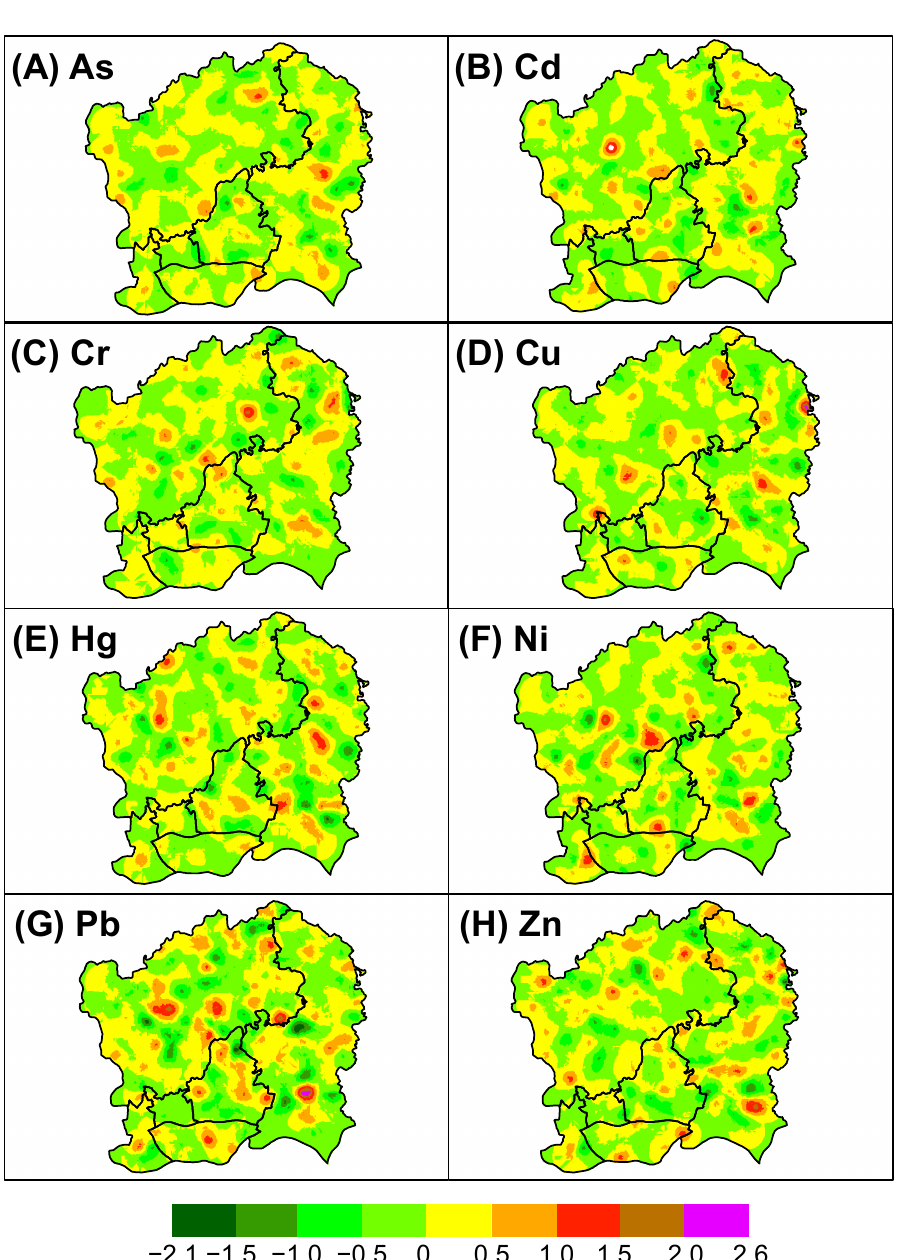
Figure 4. The cokriging maps of the spatial components for eight heavy metals at the short-range scale.